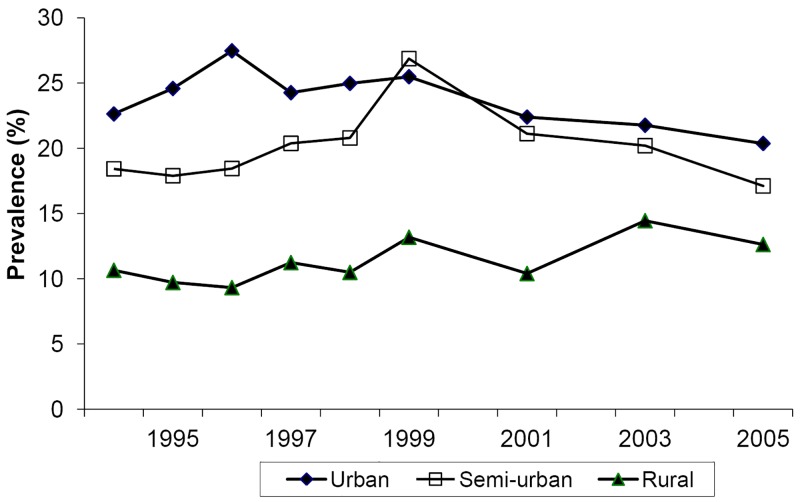
Prevalence of HIV in women attending antenatal clinics in Malawi 1994–2005.Unweighted means. The number of sites was constant over this period. Data courtesy Malawi National AIDS Commission.